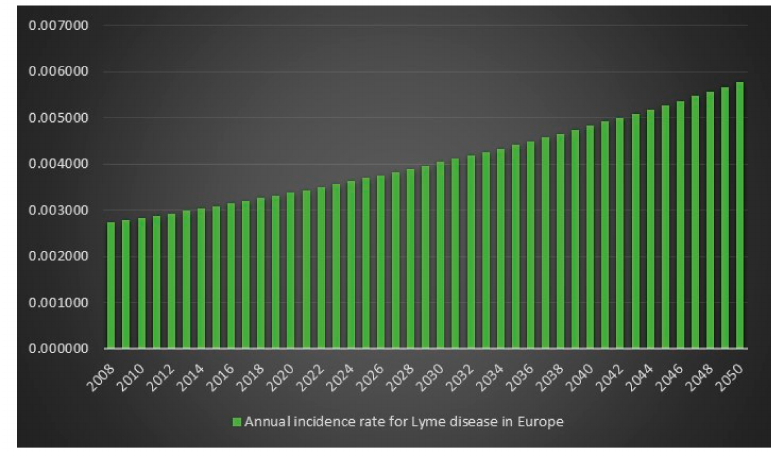
Figure 14. Annual incidence rate of Lyme disease in Europe between the years 2008 to 2050.